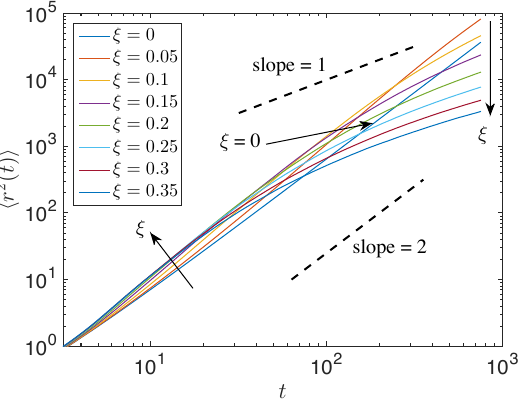
for different ξ in the log-log scale. The line is a guide to the eye. Arrows indicate Figure 7. r 2 ( t ) (cid:104) (cid:105) the trend for ξ >